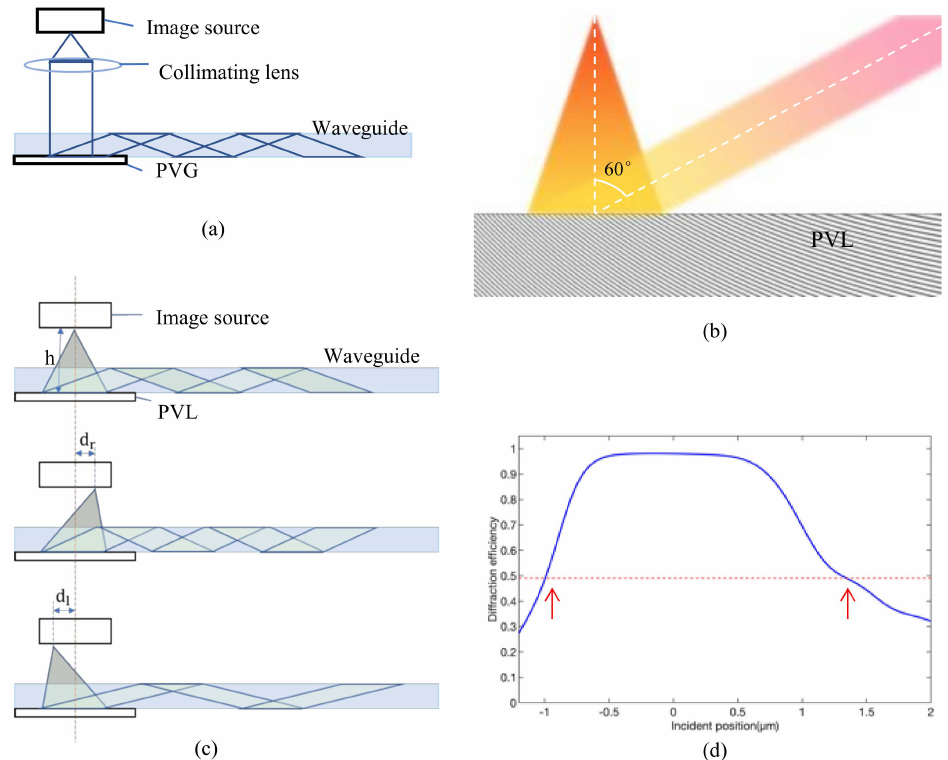
Figure 5. ( a ) Schematic diagram of conventional waveguide in-coupling scheme, using collimat- ing lens. ( b ) Schematic diagram of PVL simulation structure applied to in-coupling elements. ( c ) Schematic diagram of PVL-applied waveguide system, and its FOV calculation. ( d ) Variation of diffraction efficiency with point light source position. The arrows indicate the interval ensuring that the diffraction efficiency is higher than 50% of the maximum